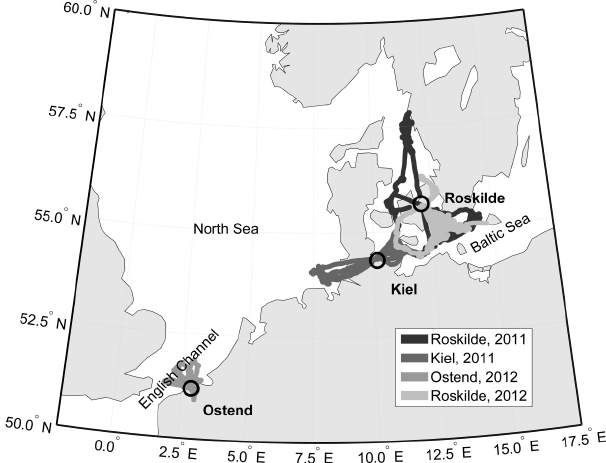
Figure 2. Map showing the flight tracks over the monitored sea regions for the different measurement campaigns; Roskilde (10–23 June 2011), Kiel (28 September–2 October 2011), Os- tend (30 May–1 June 2012) and Roskilde (28 August–6 Septem- ber 2012).